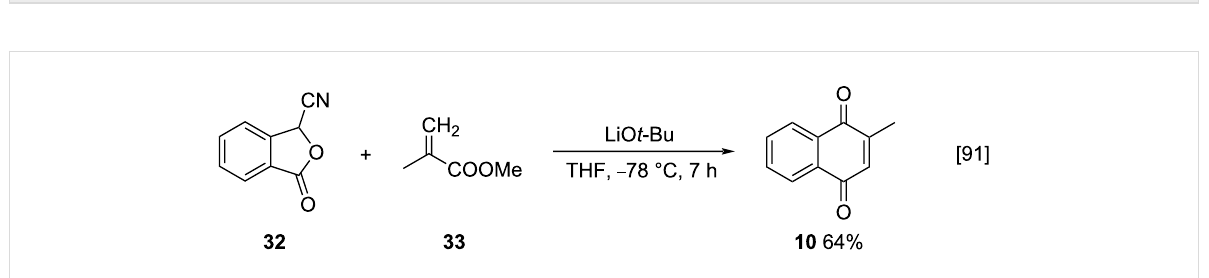
Scheme 6: Synthesis of menadione ( 10 ) using p -cresol as a synthetic precursor.